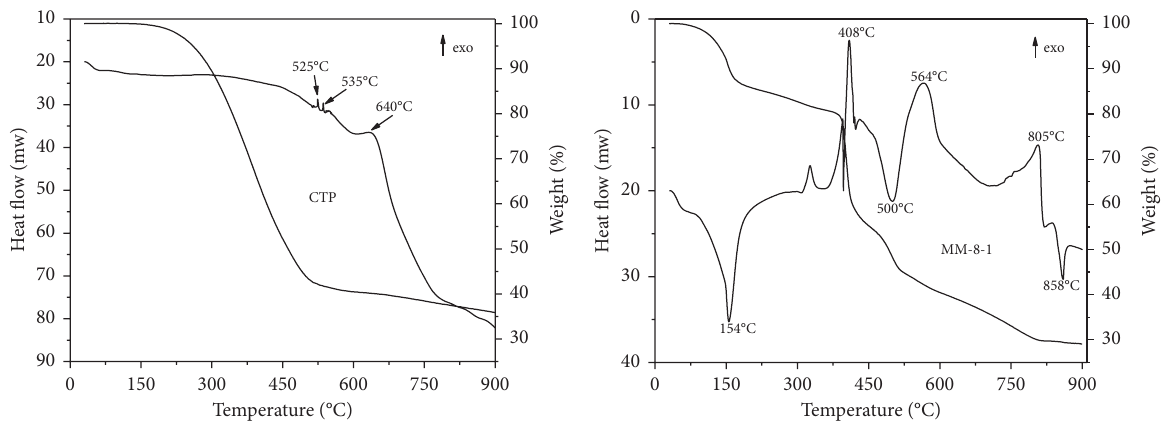
Figure 1: TG-DSC curves of parent CTP and MM-8-1.